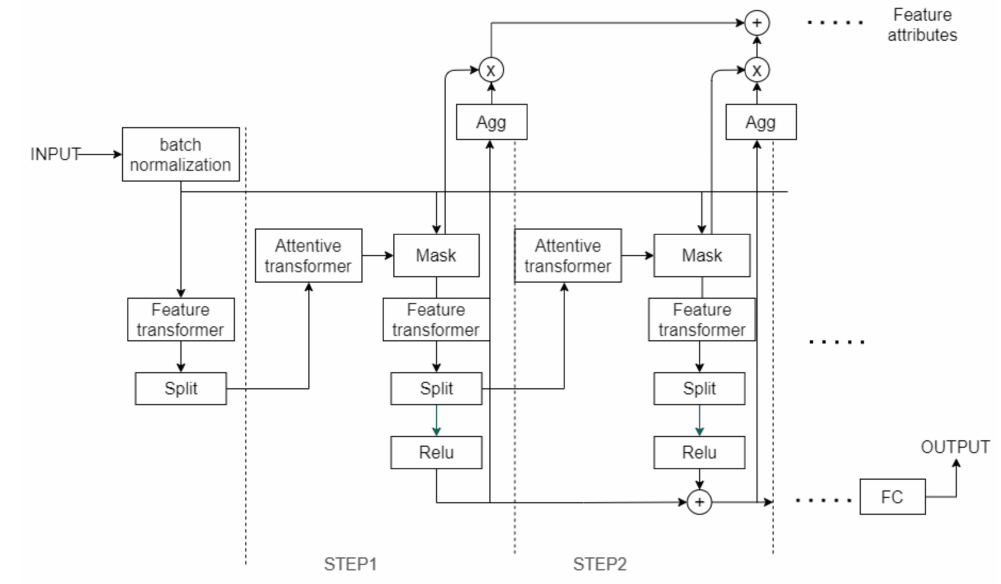
Figure 3. The encoder of the TabNet